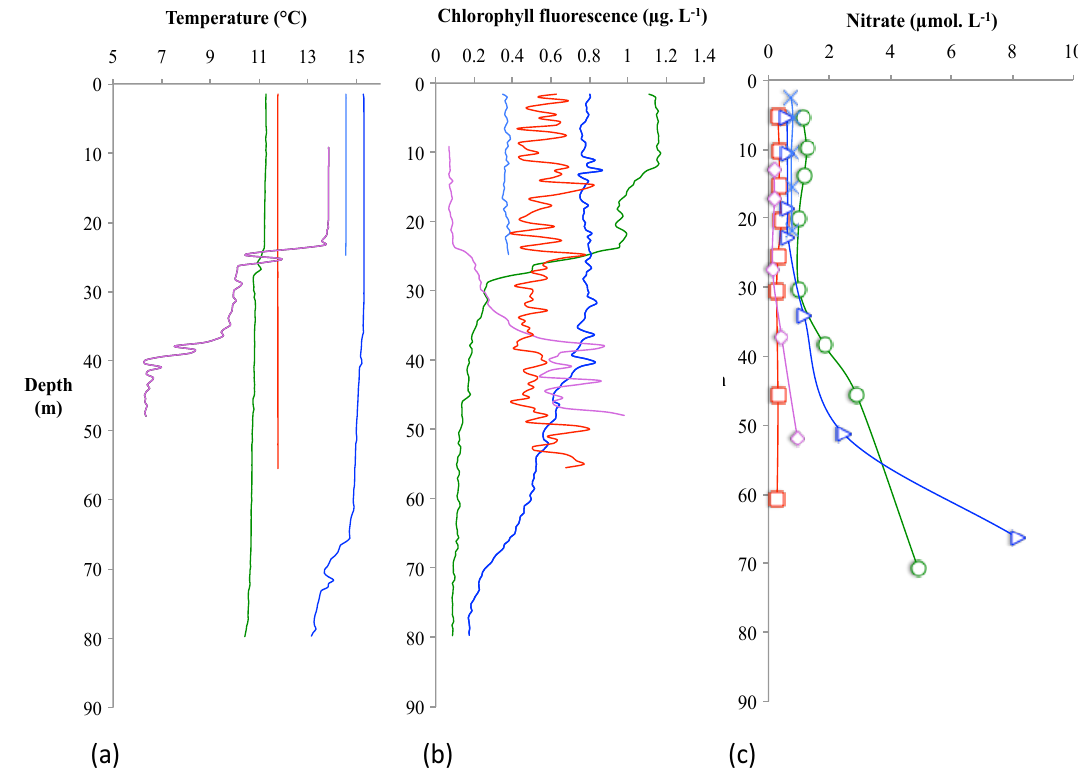
Figure 2. Vertical profiles of (a) temperature ( ◦ C), (b) chlorophyll fluorescence (µgL − 1 ) and (c) nitrate (µmolL − 1 ) illustrating oceano- graphic setting of each of the five main bioassay experiments at the time of the setup. Temperature and fluorescence data were obtained from the CTD, and nitrate concentrations from discrete measurements of water column samples. Each colour/symbol corresponds to a bioassay: E1 (green, circles), E2 (red, squares), E3 (dark blue, triangles), E4 (light blue, crosses) and E5 (purple,